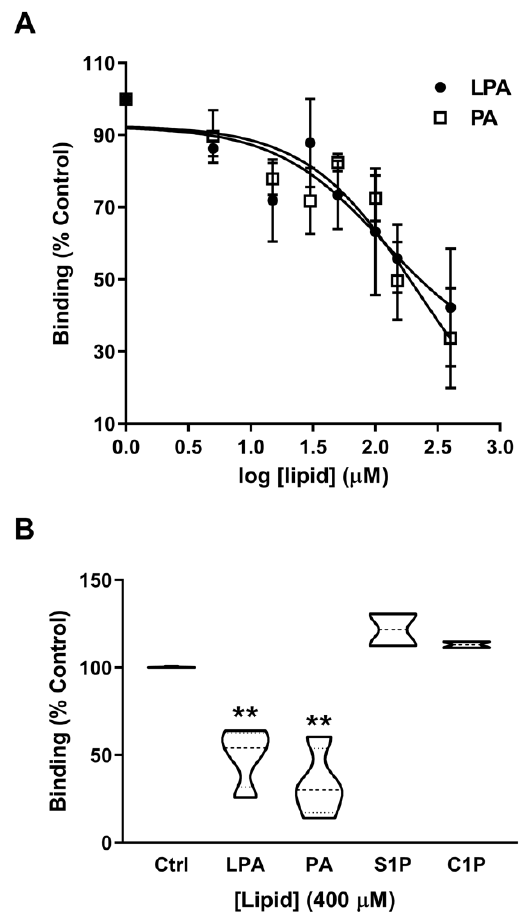
Figure 7. PA competes with LPA for binding to LPA receptors. ( A ) Myoblast membranes were incubated with 10 µ M [ 3 H]LPA in the presence of the indicated concentrations of unlabeled PA or LPA, as indicated. Non-specific binding was measured in the absence cell of membranes. Results are the mean ± SEM of three independent experiments performed in triplicate. Radioactivity of filter-bound radionuclide was quantified by liquid scintillation counting, as indicated in the Materials and Methods section. ( B ) The competition binding assays were performed with 10 µ M [ 3 H]LPA in the presence of 400 µ M PA, 400 µ M LPA, 400 µ M S1P or 400 µ M C1P, as indicated. Non-specific binding was measured in the absence of myoblast membranes. Results are the mean ± SEM of three independent experiments performed in triplicate. (** p < 0.01). Radioactivity of filter-bound radionuclide was quantified by liquid scintillation counting.